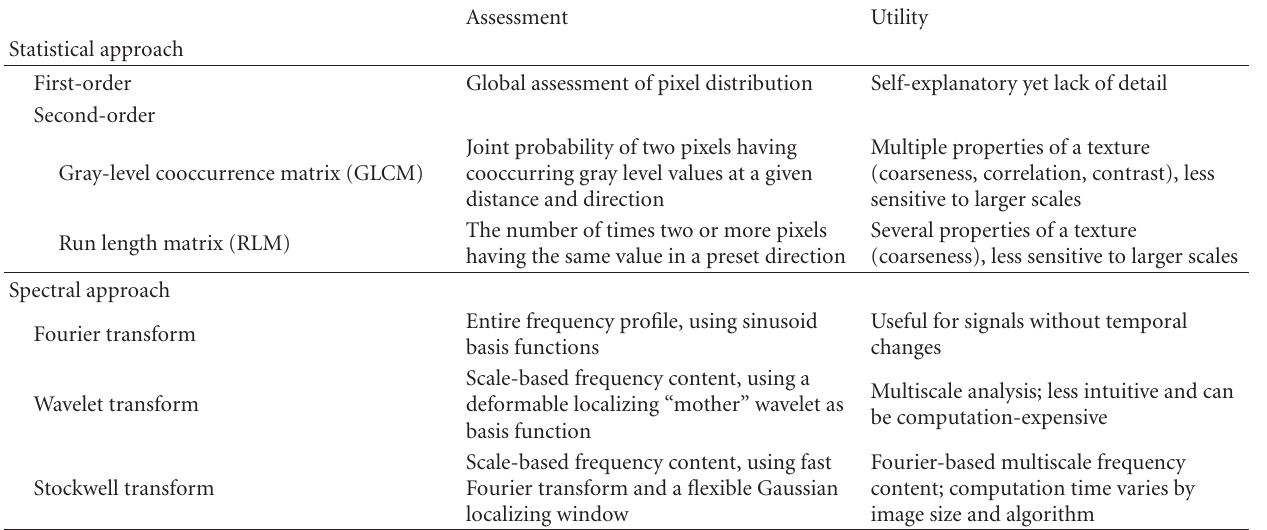
Table 1: Overview of common texture analysis approaches in